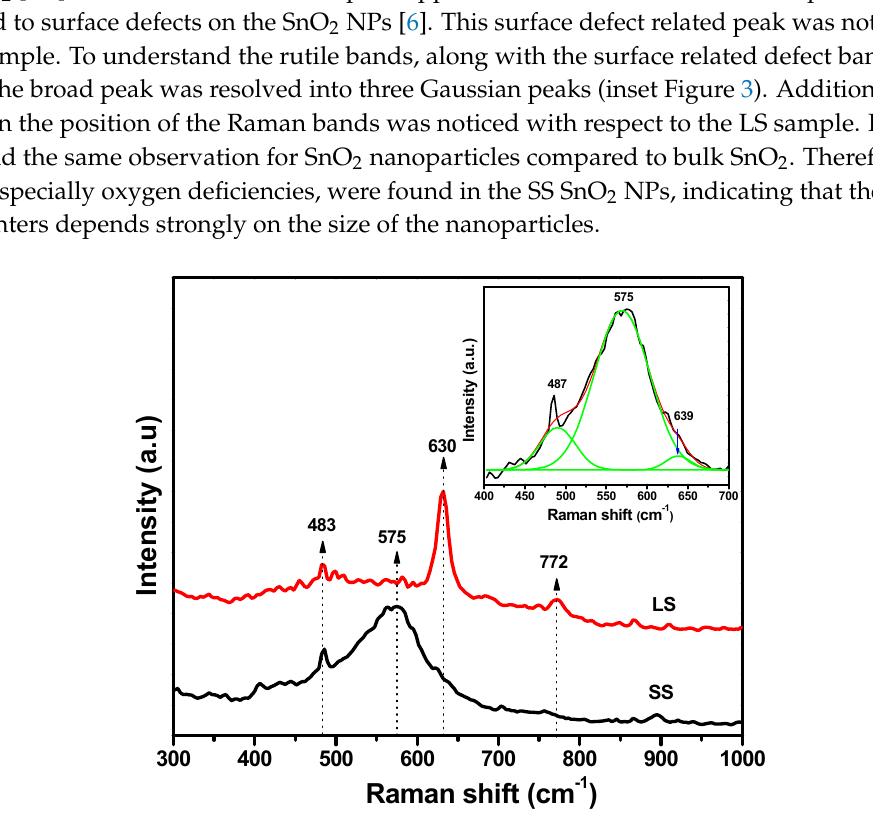
Figure 3. Raman spectra of the SS and LS samples; inset shows the magnified part of SS sample.